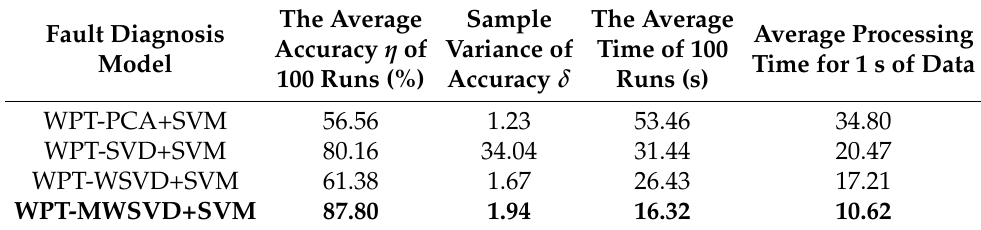
Table 4. Classification results under different